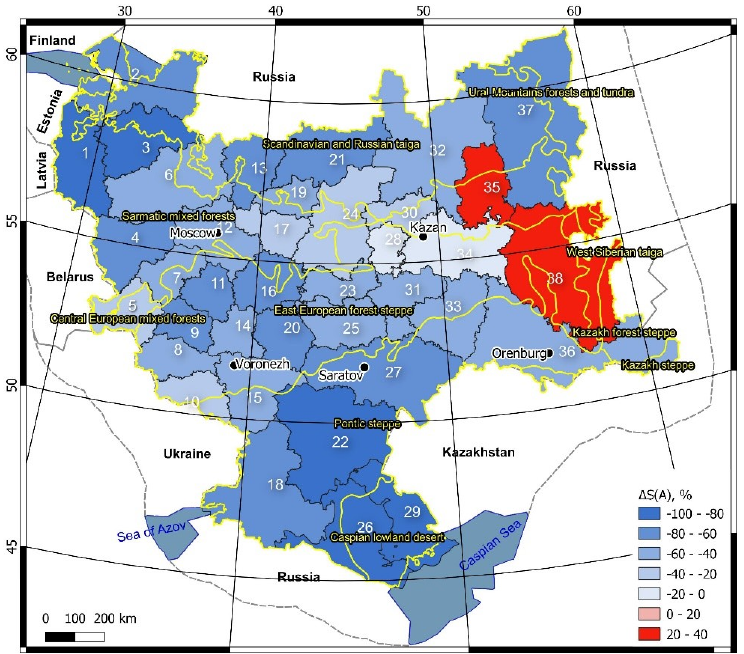
Figure 6. Relative changes in cultivated land area under annual crops ( ∆ S(A)) within the analyzed administrative regions of European Russia between 1970–1987 and 1996–2017. For other symbols, see Figures 2 and 3.